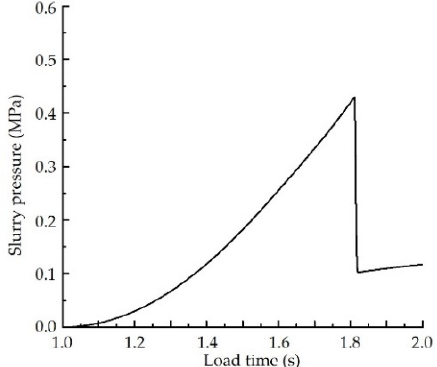
Figure 7. Injection point slurry pressure monitoring.